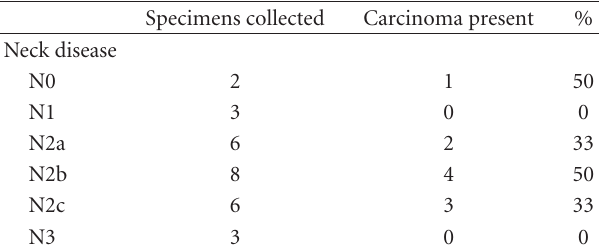
Table 3: Pathology results of neck dissection